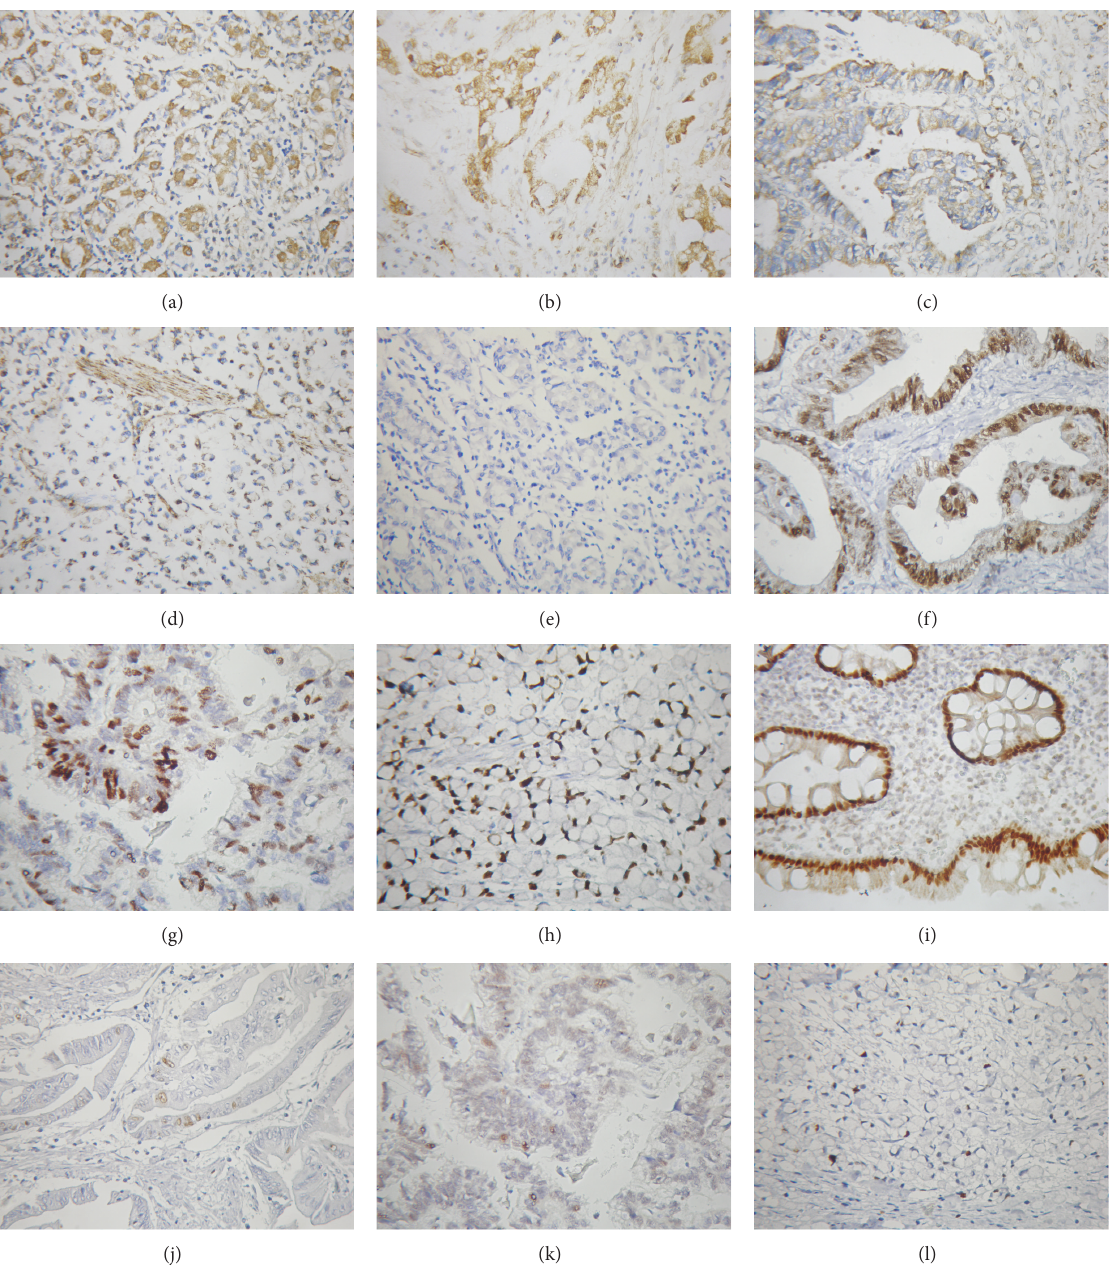
Figure 1: Immunohistochemical staining in GAC and ANM tissue. (a) GPX1 expression in ANM tissue (score 3). (b) GPX1 expression in well- differentiated GAC (score 3). (c) GPX1 expression in well-differentiated GAC (score 2). (d) GPX1 expression in signet-ring cell GAC (score 0). (e) CDX2 expression in ANM tissue (negative). ((f) and (g)) CDX2 expression in well-differentiated GAC (positive). (h) CDX2 expression in signet-ring cell GAC (negative). (i) CDX2 expression in normal colon mucosa (positive). ((j) and (k)) Ki67 expression in well-differentiated GAC (negative). (l) Ki67 expression in signet-ring cell GAC (negative). Original magnification: ×